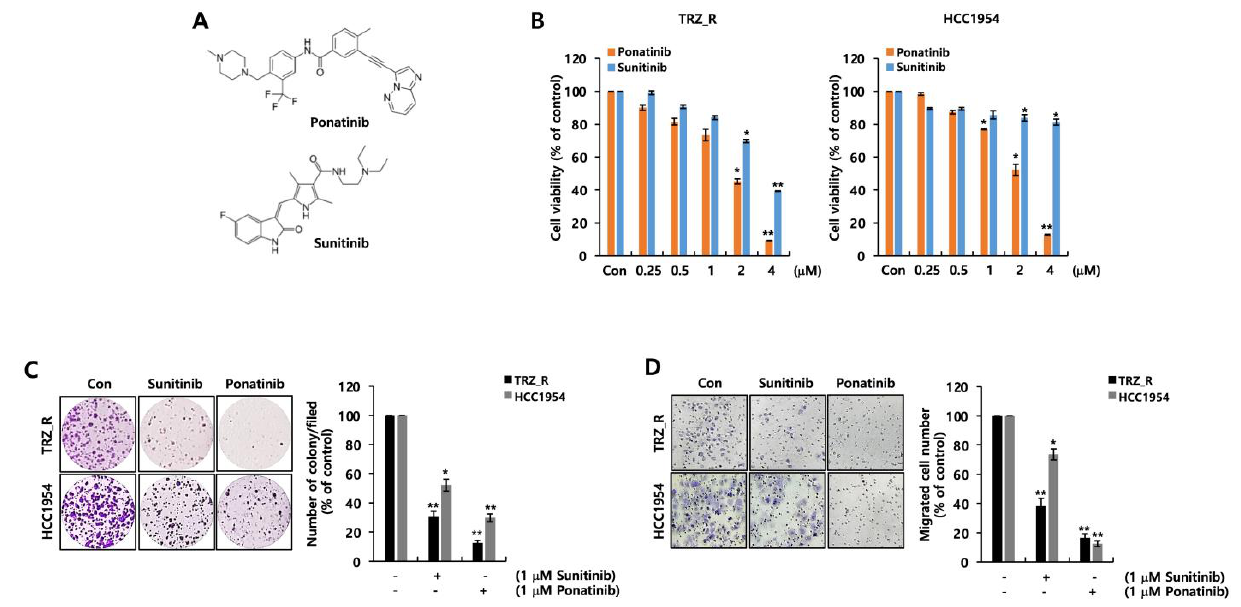
at 2 µ M decreased the viability of BT474 TRZ_R and HCC1954 cells to 69.8 ± 1.0% and 84.0 ± 1.9% (compared to control), respectively (Figure 3B). In particular, the pharmacolog- on the cell viability of both cells (Figure 3B).